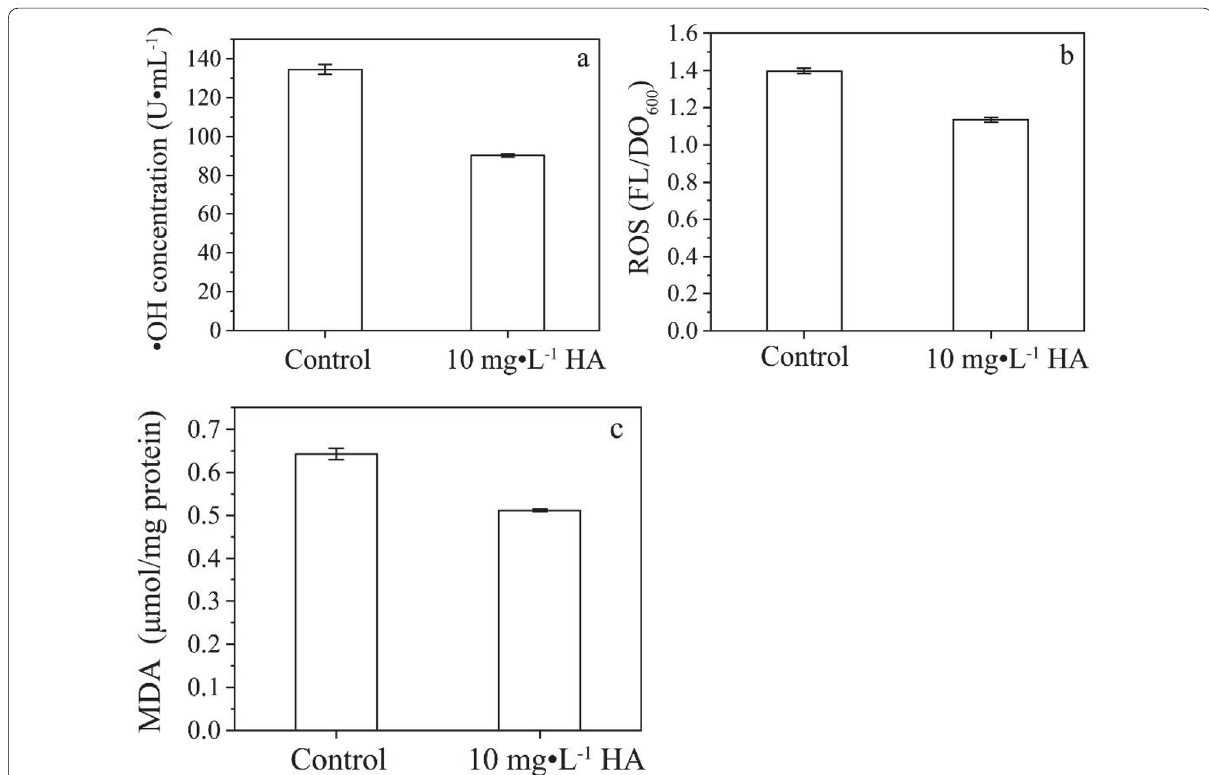
Fig. 12 Effects of HA on OH, intracellular ROS and MDA contents for C09. a ·